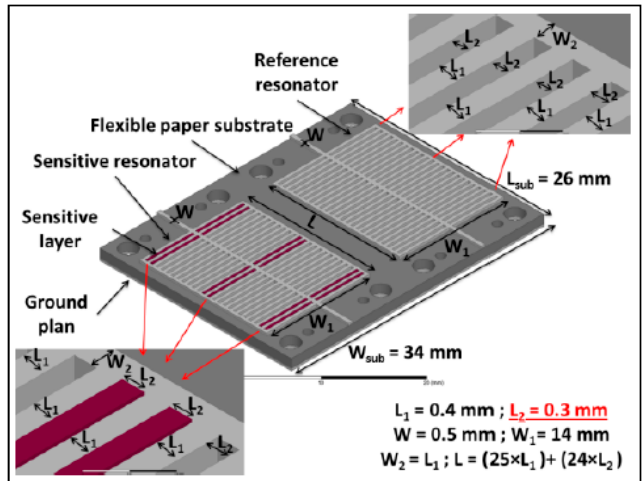
Figure 4. Design of the gas sensor.